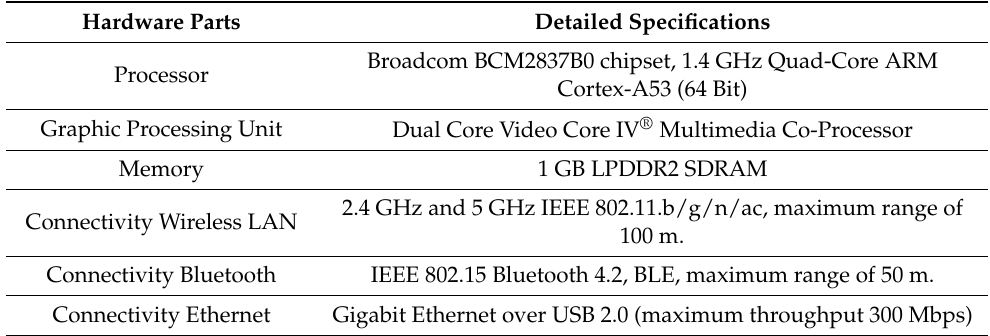
Table 7. The detailed specifications of the smart glasses